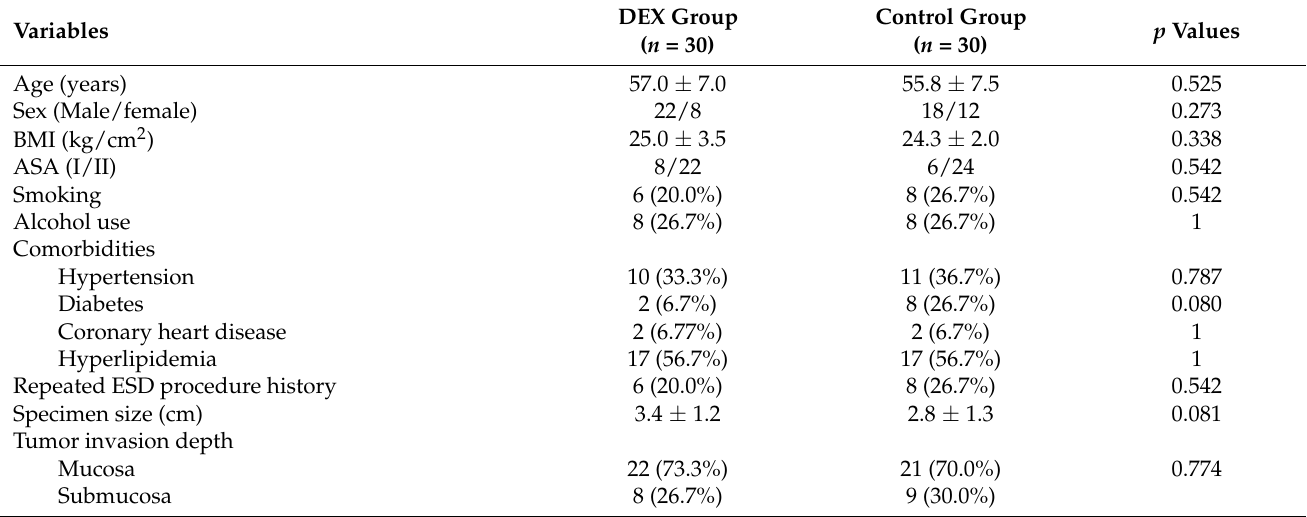
Table 2. Incidence of postoperative moderate to severe pain and dosage of morphine.